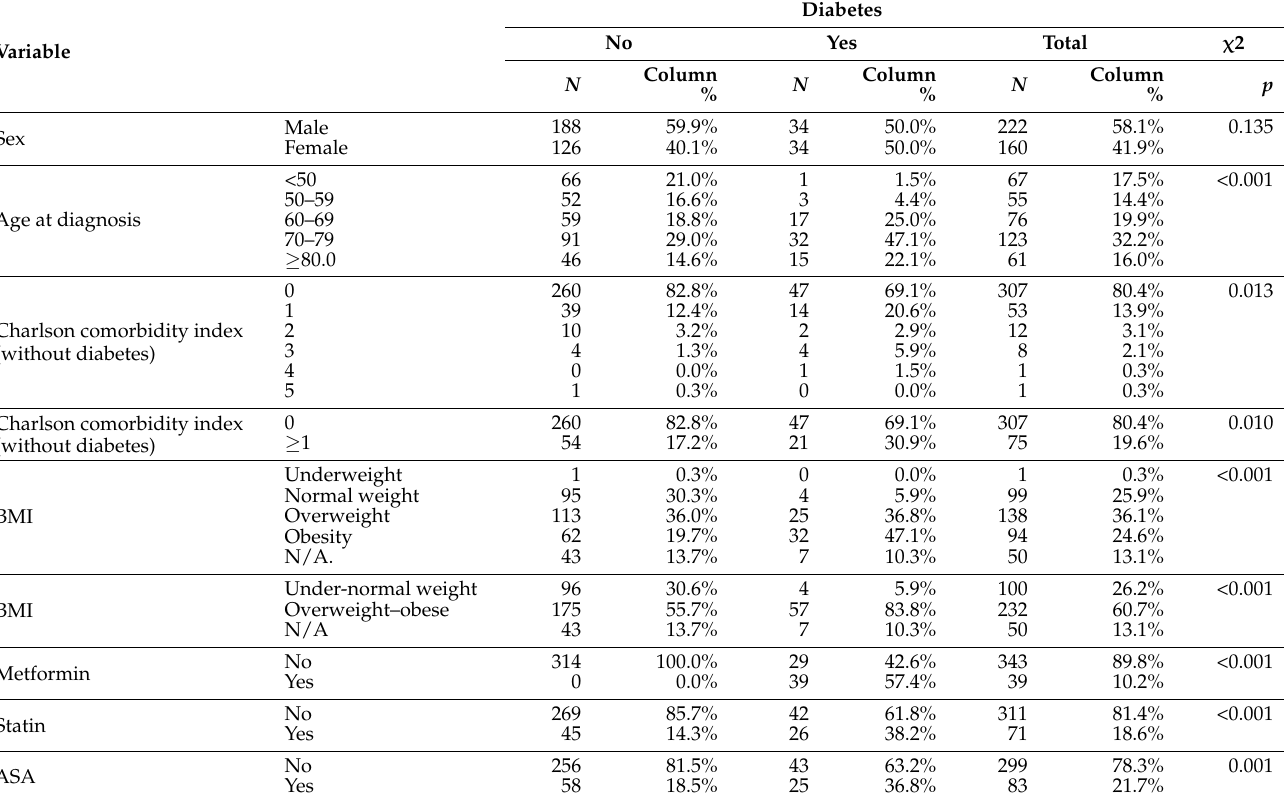
Table 1. Patients clinico-pathological characteristics according to a diagnosis of diabetes ( n =